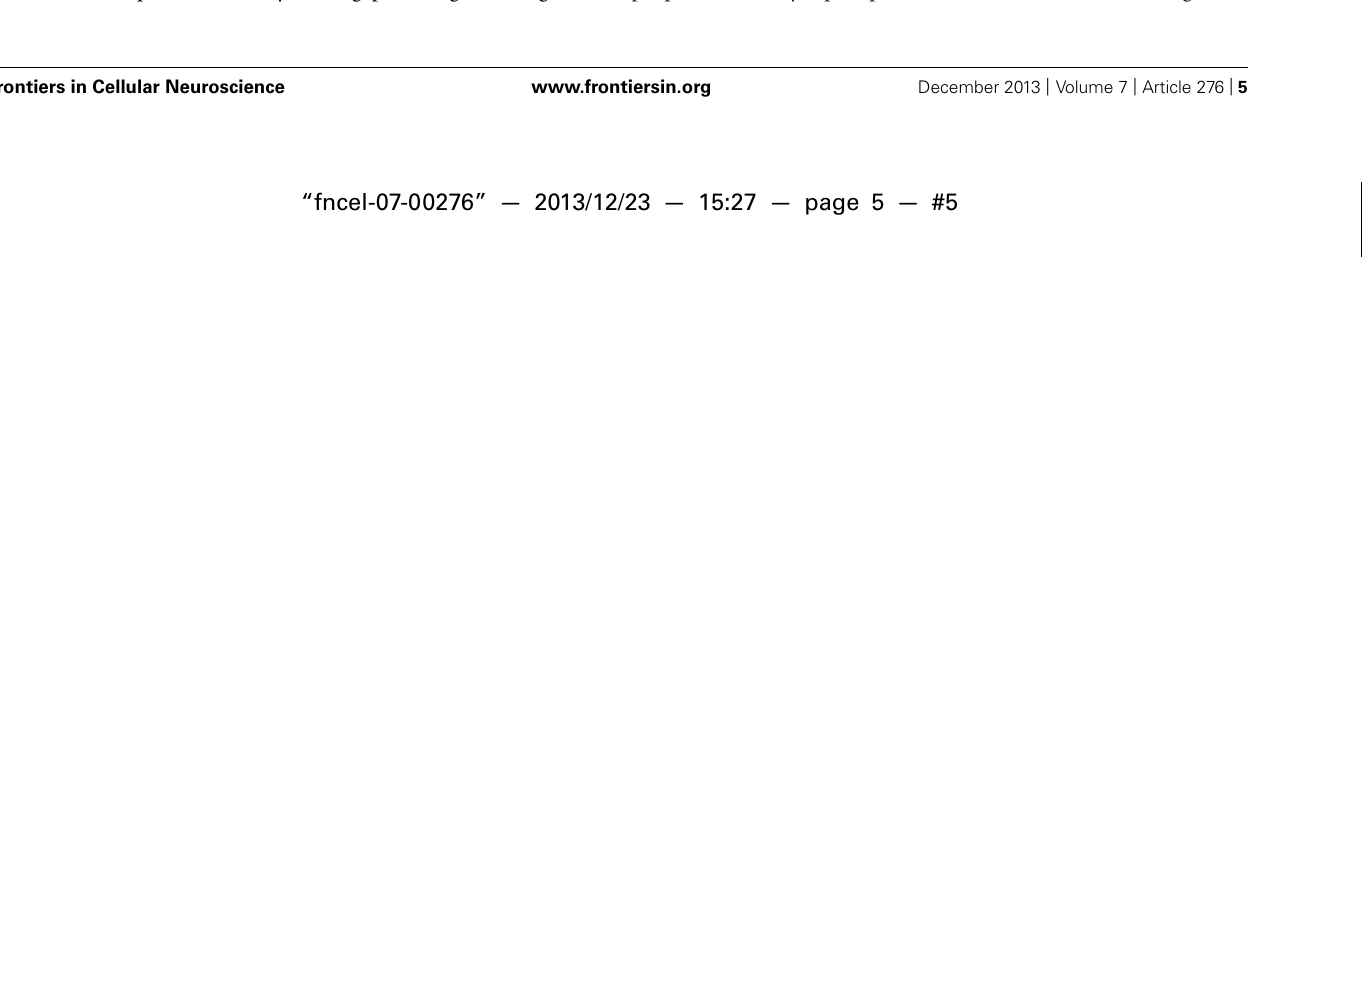
(300 μ M), the same stimulus produced a strong inhibition but delayed spike firing was eliminated.The inset in (B) shows that the LTS induced by a hyperpolarizing current pulse was strongly reduced by Ni 2 + . All data from the same